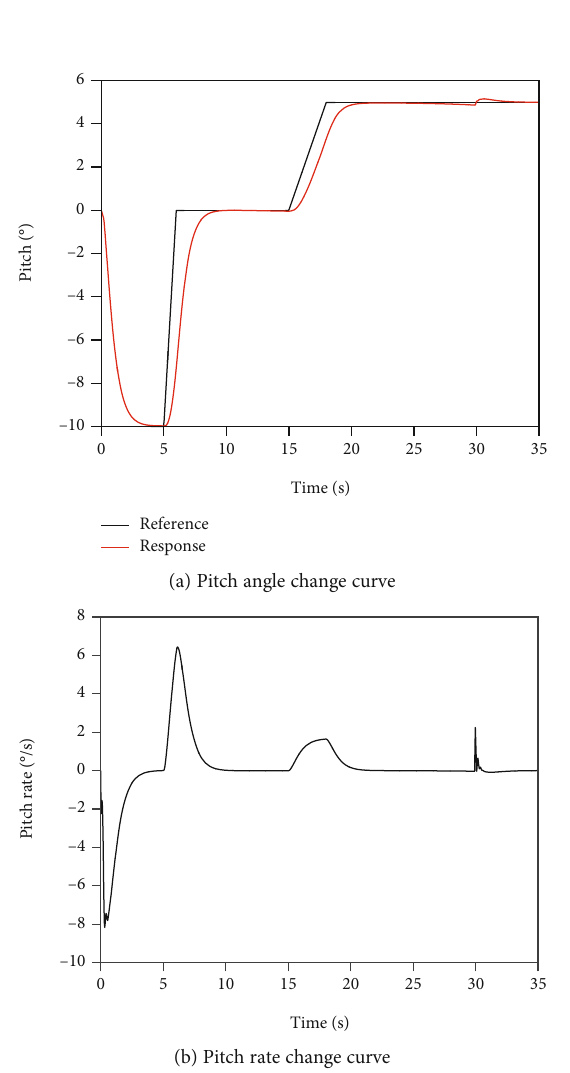
Figure 15: The pitch angle and pitch rate change